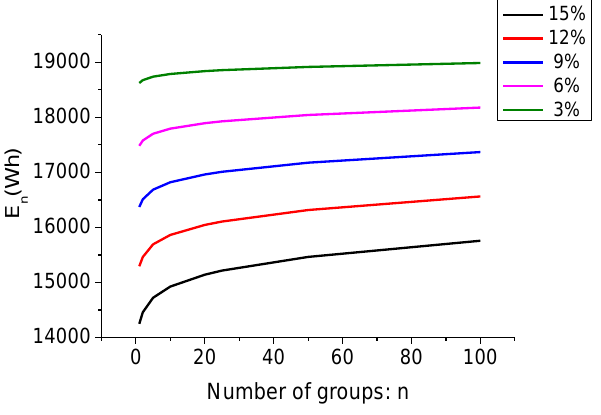
Figure 6. E n under different capacity inconsistency levels.